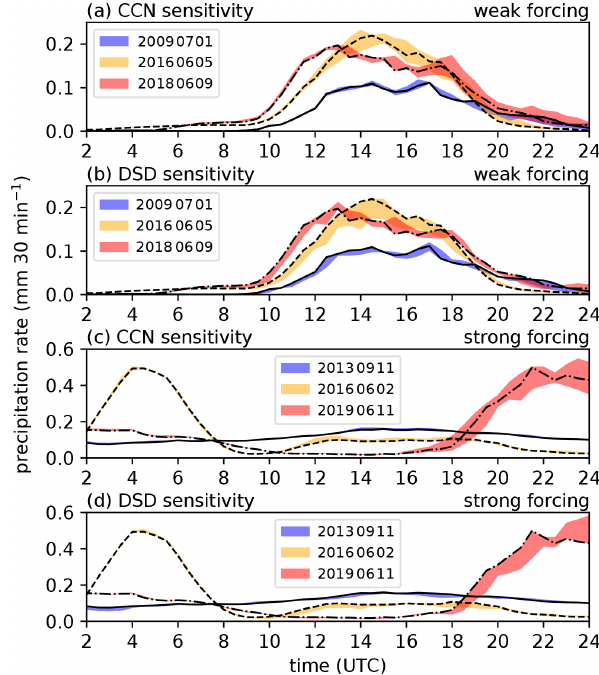
Figure 6. Domain-averaged precipitation rates for weak forcing (a, b) and strong forcing (c, d) . The color-coded areas indicate the range between the minimum and maximum precipitation rate for all CCN sensitivities in panels (a) and (c) and all shape parame- ter sensitivities in panels (b) and (d) for each case. The black lines indicate the respective reference run with continental CCN concen- tration and a shape parameter of